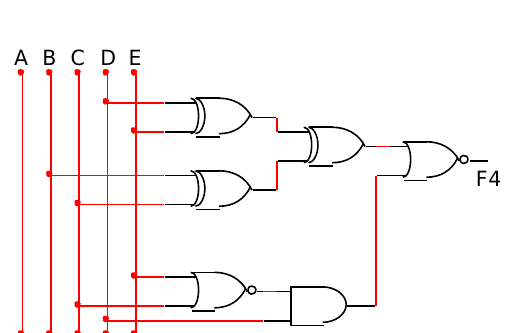
Figure 11. Designed circuit for F 4 using proposed approach.